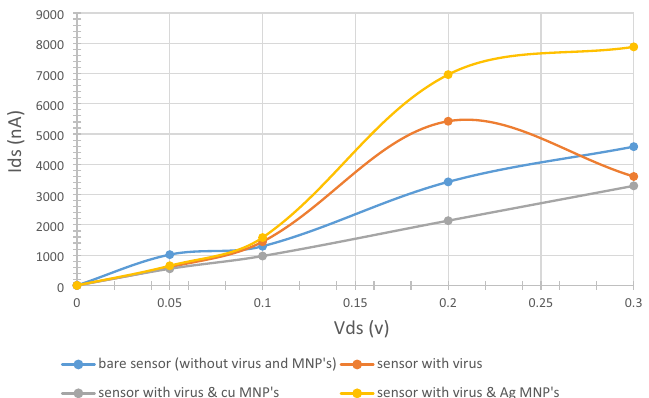
Figure 12. I-V curves of bare (without antibodies and MNP’s), virus-bound and MNPs decorated sensor at V g = 1 V. Produced by Excel based on the data generated from QuantumATK